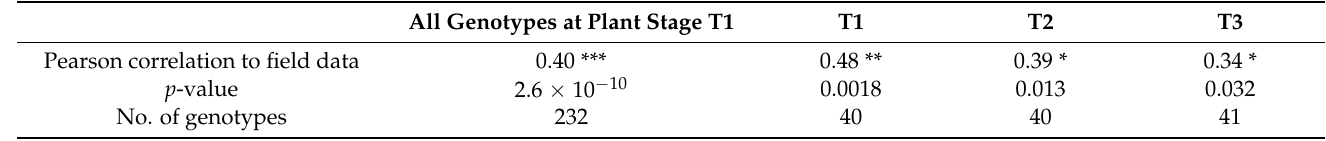
Table 5. Pearson correlation between seedling and adult plant resistance against leaf rust based on greenhouse and field testing, respectively. The whole genotypic set was tested as 10-day old seedlings (EC 12), while selected genotypes were examined at plant developmental stages T1 (EC 12), T2 (EC 19), and T3 (EC 25) within replicated greenhouse trials. All Genotypes at Plant Stage T1 T1 T2